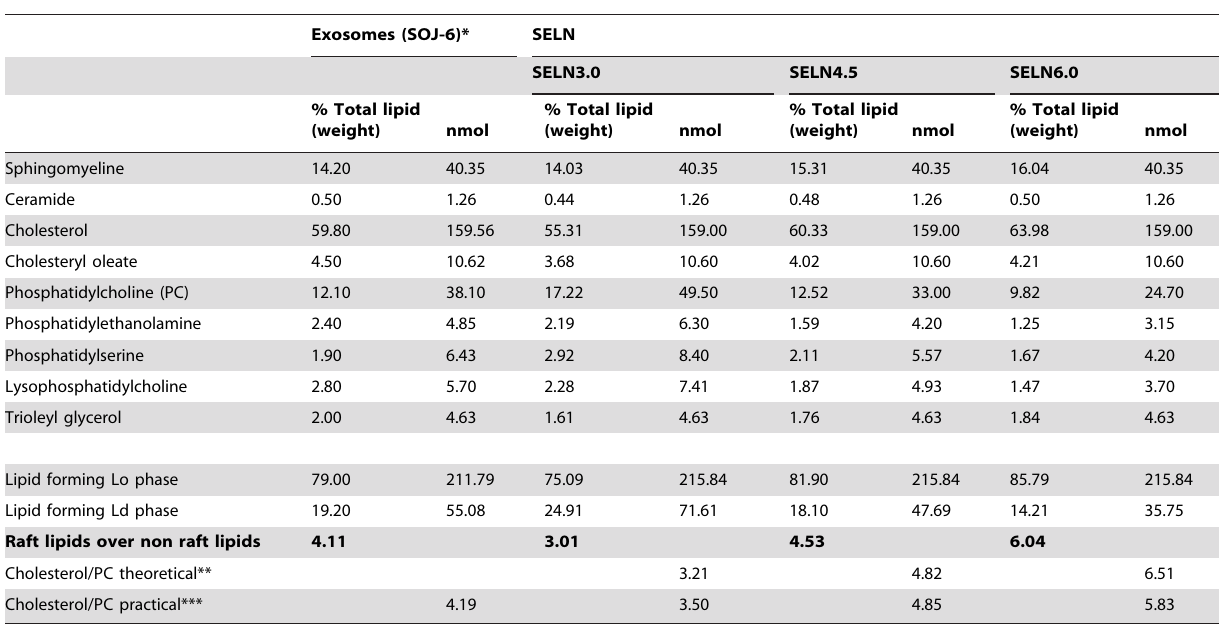
Table 1. Lipid composition of synthetic exosome-like nanoparticles